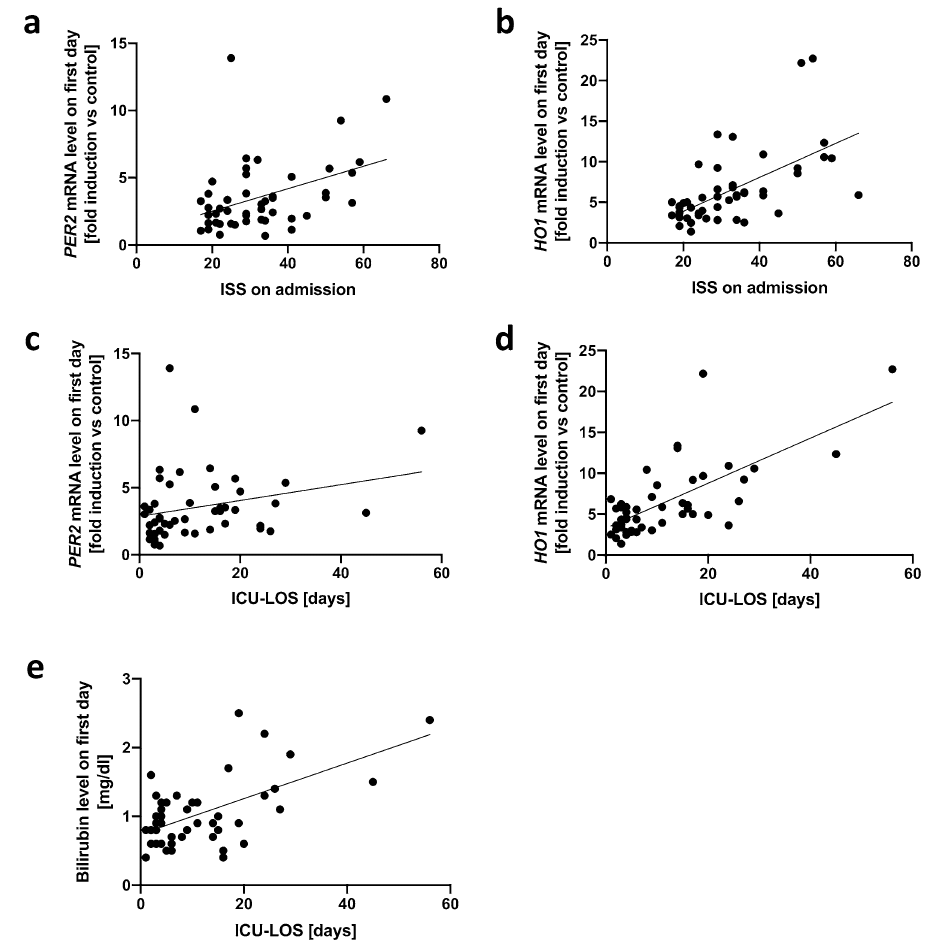
Figure 3. Correlation of systemic PER2 and HO1 expression with trauma severity and length of ICU stay. Linear regression curves of (a) patients’ ISS (trauma severity) and PER2 expression (Spearman: r = 0.375, P = 0.009, Linear Regression: r 2 = 0.166, P = 0.004), ( b) patients’ ISS and HO1 expression (r = 0.603, P < 0.001, r 2 = 0.346, P < 0.001), (c) PER2 expression and time spent in the ICU (r = 0.340, P = 0.018, r 2 = 0.067, P =